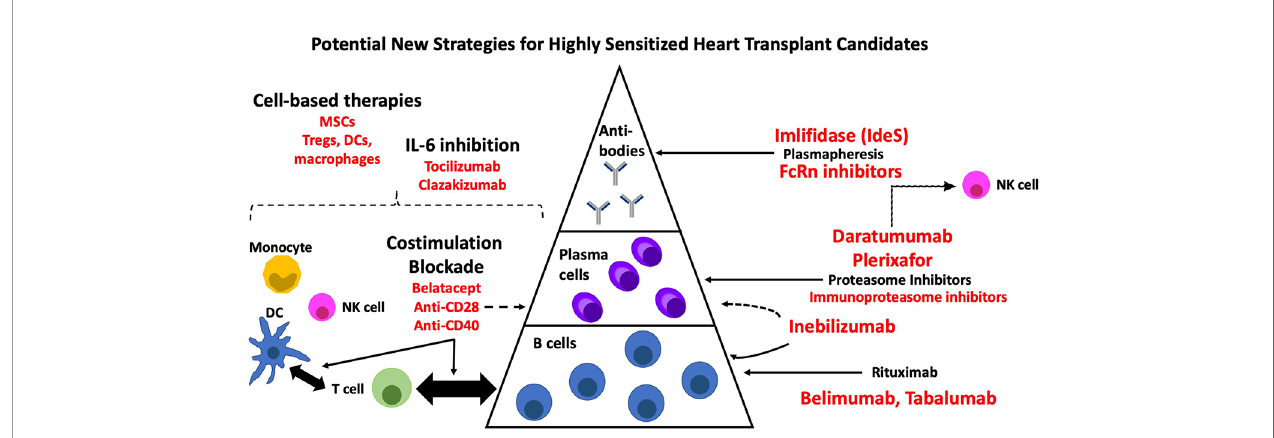
FIGURE 2 | New therapies with potential for desensitization in heart transplantation. DC, dendritic cell; MSC, mesenchymal stromal cell; NK, natural killer